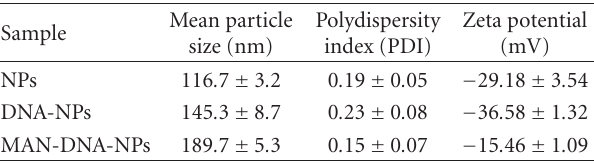
Table 1: Particle size and Zeta potential of NPs, DNA-NPs, and MAN-DNA-NPs (mean ± SD, n =